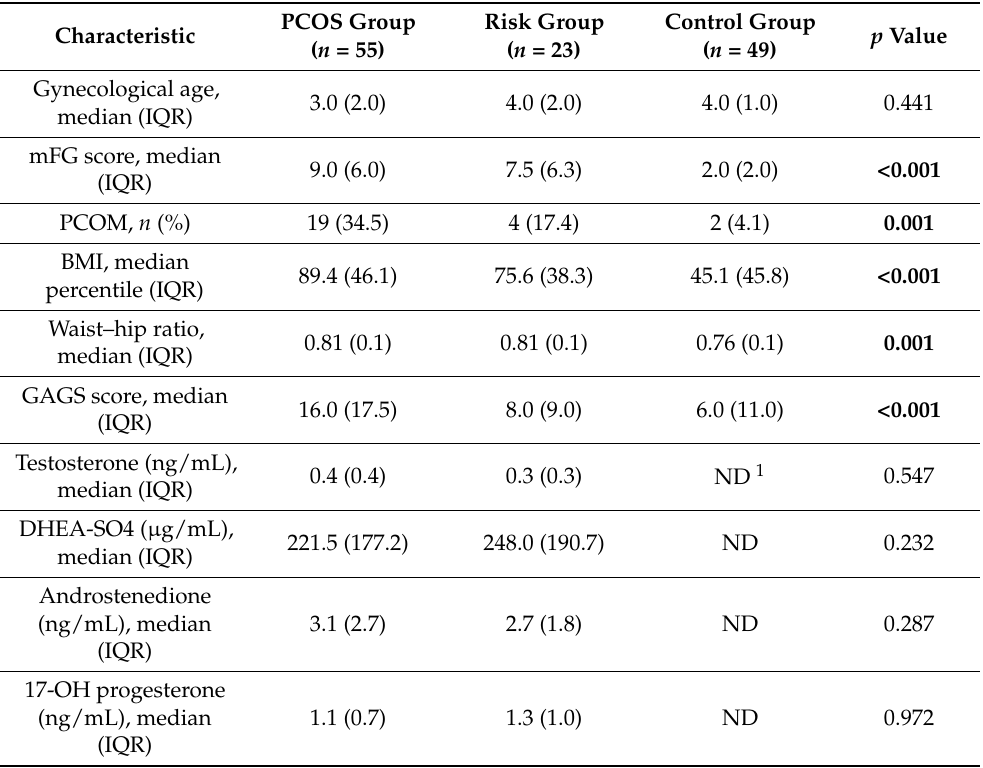
Table 1. Characteristics of the study